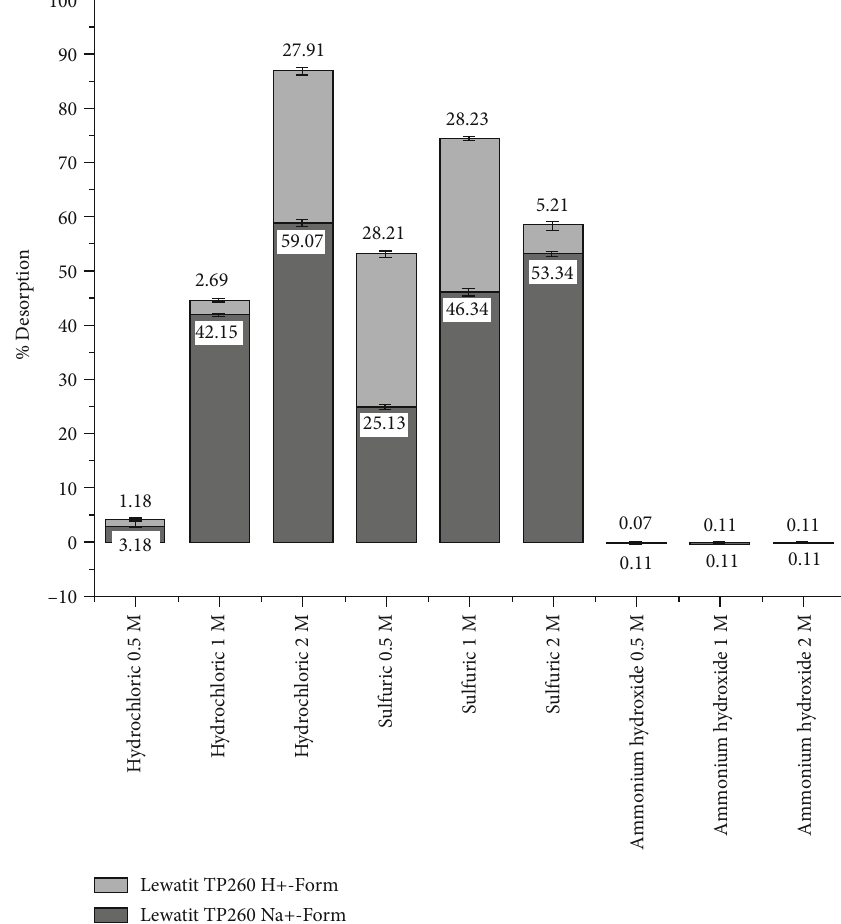
Figure 10: Desorption e ffi ciency of copper (II) ions using Lewatit TP260 chelating resin as an adsorbent with 0.5M, 1M, and 2 M concentrations of HCl, H SO , and NH OH desorbing substances, 2 4 4